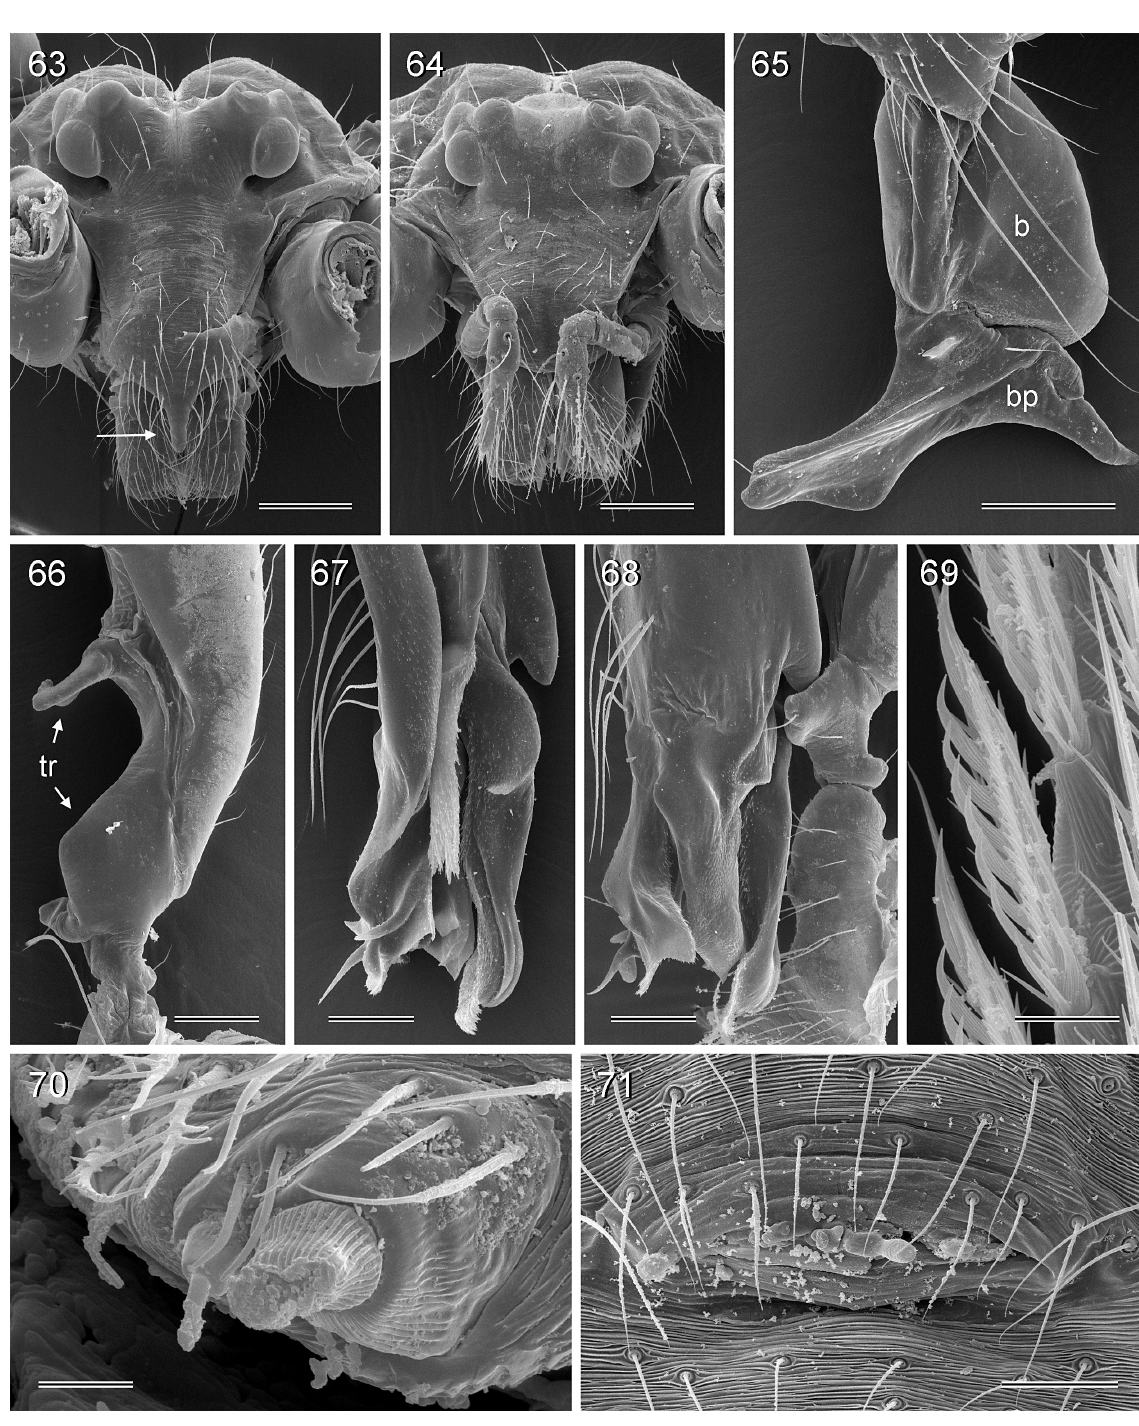
Figs 63–71. Savarna tessellata (Simon, 1901). 63–64 . Male and female prosomata, frontal views (arrow points at clypeus process). 65 . Left genital bulb (b), retrolateral view (bp = bulbal process). 66 . Right male palpal trochanter (tr), prolateral view. 67 . Right procursus tip, prolateral view. 68 . Left procursus tip, retrolateral view. 69 . Comb-hair on male right tarsus 4, prolateral view. 70 . Male ALS. 71 . Male gonopore. Scale bars: 69–70 = 10 µm; 71 = 50 µm; 66–68 = 100 µm; 63–65 =200